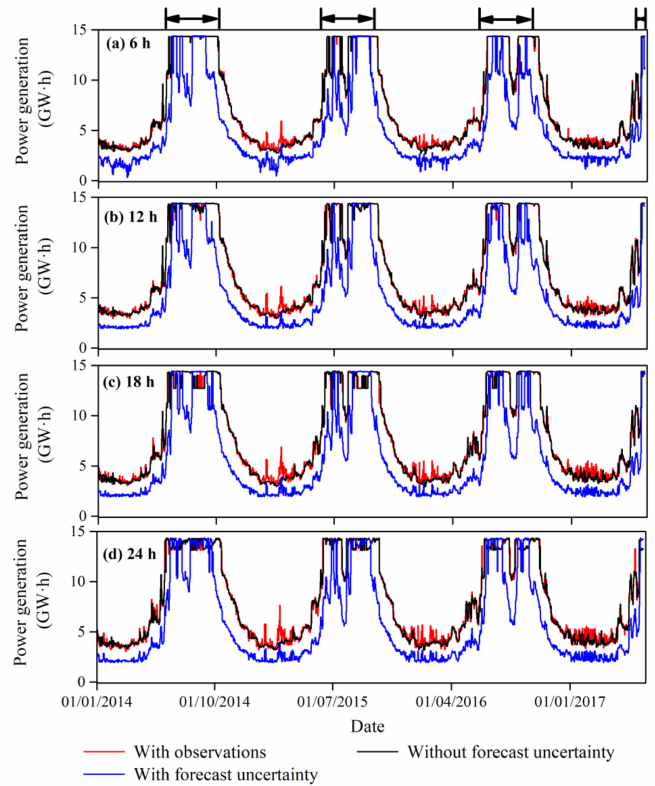
Figure 11. Temporal series of the power generation capacity that was optimized using the raw and ensemble inflow forecast with 6 h ( a ), 12 h ( b ), 18 h ( c ), and 24 h ( d ) lead times, which were compared with those derived from observations. The time intervals covered by double-headed arrows represent flood periods.